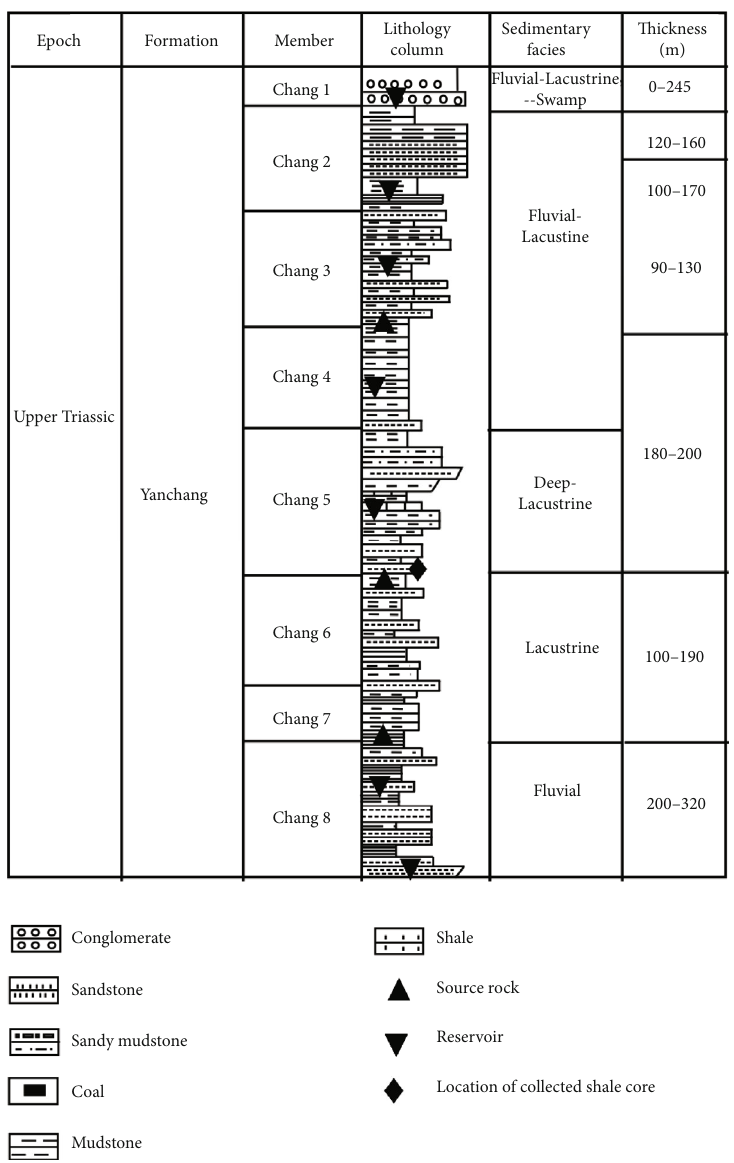
Figure 2: Stratigraphic column and depositional environment of the upper Triassic Yanchang Formation in the Ordos Basin, NW